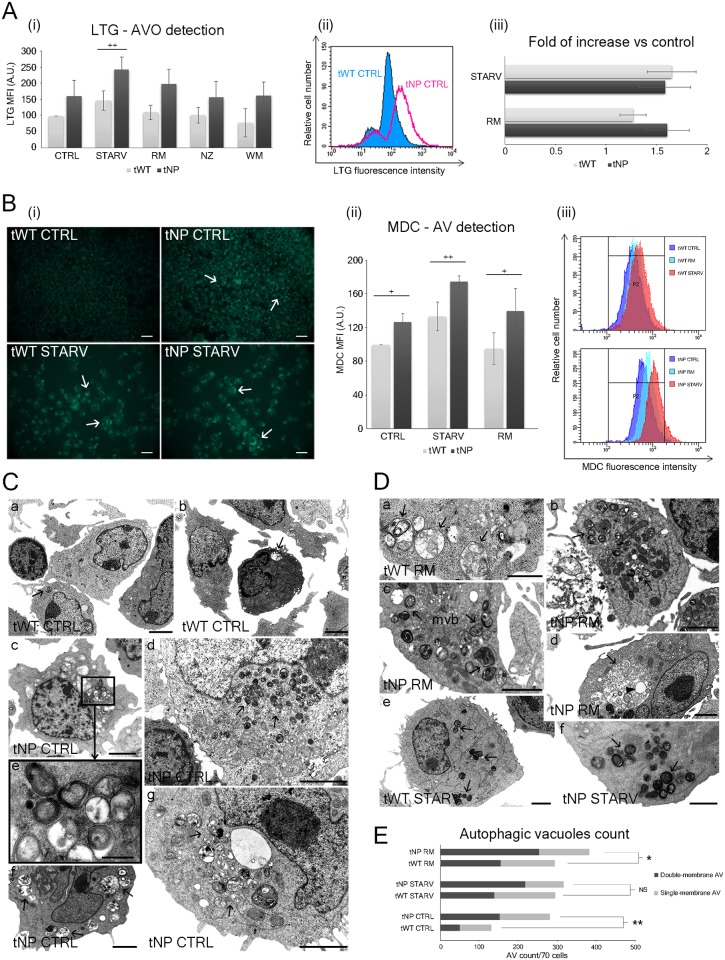
Autophagic Vacuole (AV) detection and endocytic compartment evaluation.(A) Acidic vesicular organelle (AVOs) detection by LysoTracker Green (LTG) in flow cytometry. (i) Statistical histogram of MFI variation of LTG in tWT and tNP cells for each experimental condition. Mean values were converted to arbitrary units (A.U.) setting control of wild-type cells as 100. Each value is expressed as a relative mean ± SD (Results from n ≥ 3 independent experiments). The difference between cell lines was determined to be significant by two-way ANOVA (***P < 0.001). Two-way ANOVA with Bonferroni post test revealed a P value < 0.01 (++P < 0.01) between tWT and tNP starved cells (ii) Flow cytometry histogram overlay showing lysotracker green MFI values of tWT and tNP basal condition. (iii) Fold increase related to histogram in (i) starved and rapamycin-treated cells in both cell lines, versus respective control. (B) Autophagic vacuole detection by Monodansylcadaverine (MDC) in fluorescence microscopy and flow cytometry. (i) Microscopy images showing monodansylcadaverine fluorescence from control and starved tWT and tNP cells. White arrows indicate cells rich in AV. Bars: 10μm. (ii) Statistical histogram depicting MFI variation of monodansylcadaverine in tWT and tNP cells for control, starved and rapamycin-treated cells. Mean values were converted to arbitrary units (A.U.) setting control of wild-type cells as 100. Each value is expressed as a relative mean ± SD (Results from n ≥ 3 independent experiments). Two-way ANOVA with Bonferroni post test revealed a P value < 0.05 (+P < 0.05) between tWT and tNP in basal condition and rapamycin treated and a P value < 0.01 (++P < 0.01) between tWT and tNP after starvation treatment (iii) Monodansylcadaverine flow cytometric histograms are overlaid to show the comparison among MFI values of basal condition, starved and rapamycin-treated samples in tWT (upper panel) and tNP (lower panel) lymphocytes. (C) TEM autophagic vacuole detection in control condition of tWT (a, b) and tNP (c-g) cells. Black arrows indicate AVs. Bars: 2 μm for a, b, c, d, f, g; 0.5 μm for e. (D) TEM autophagic vacuole detection in normal (a, e) and NP-B B lymphocytes (b, c, d, f), after nutrient deprivation (e, f) and rapamycin administration (a-d). Black arrows indicate AVs. Black arrowhead indicates a lipid droplet inside AV. Mvb: multivesicular bodies. Bars: 1 μm for a, f; 2 μm for b, c, d, e. (E) Double- and single- membrane autophagic vacuoles from tWT and tNP lymphocytes were counted in control, starvation and rapamycin conditions. Each value is expressed as an absolute number (70 cells counted/experiment). Two-way ANOVA with Bonferroni post test revealed a P value < 0.01 between tWT and tNP basal condition and a P value < 0.05 between tWT and tNP rapamycin treated.